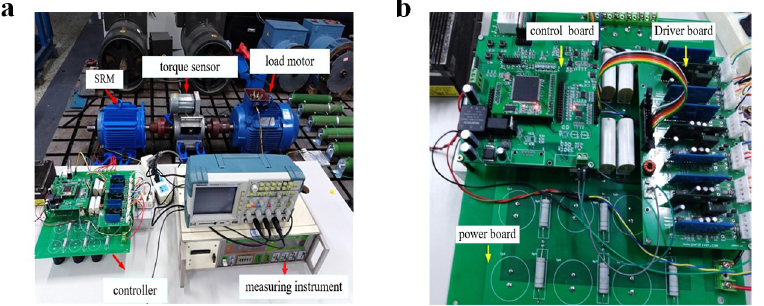
Fig 15. SRM experiment platform. (a) SRM test bench. (b) SRM control platform.